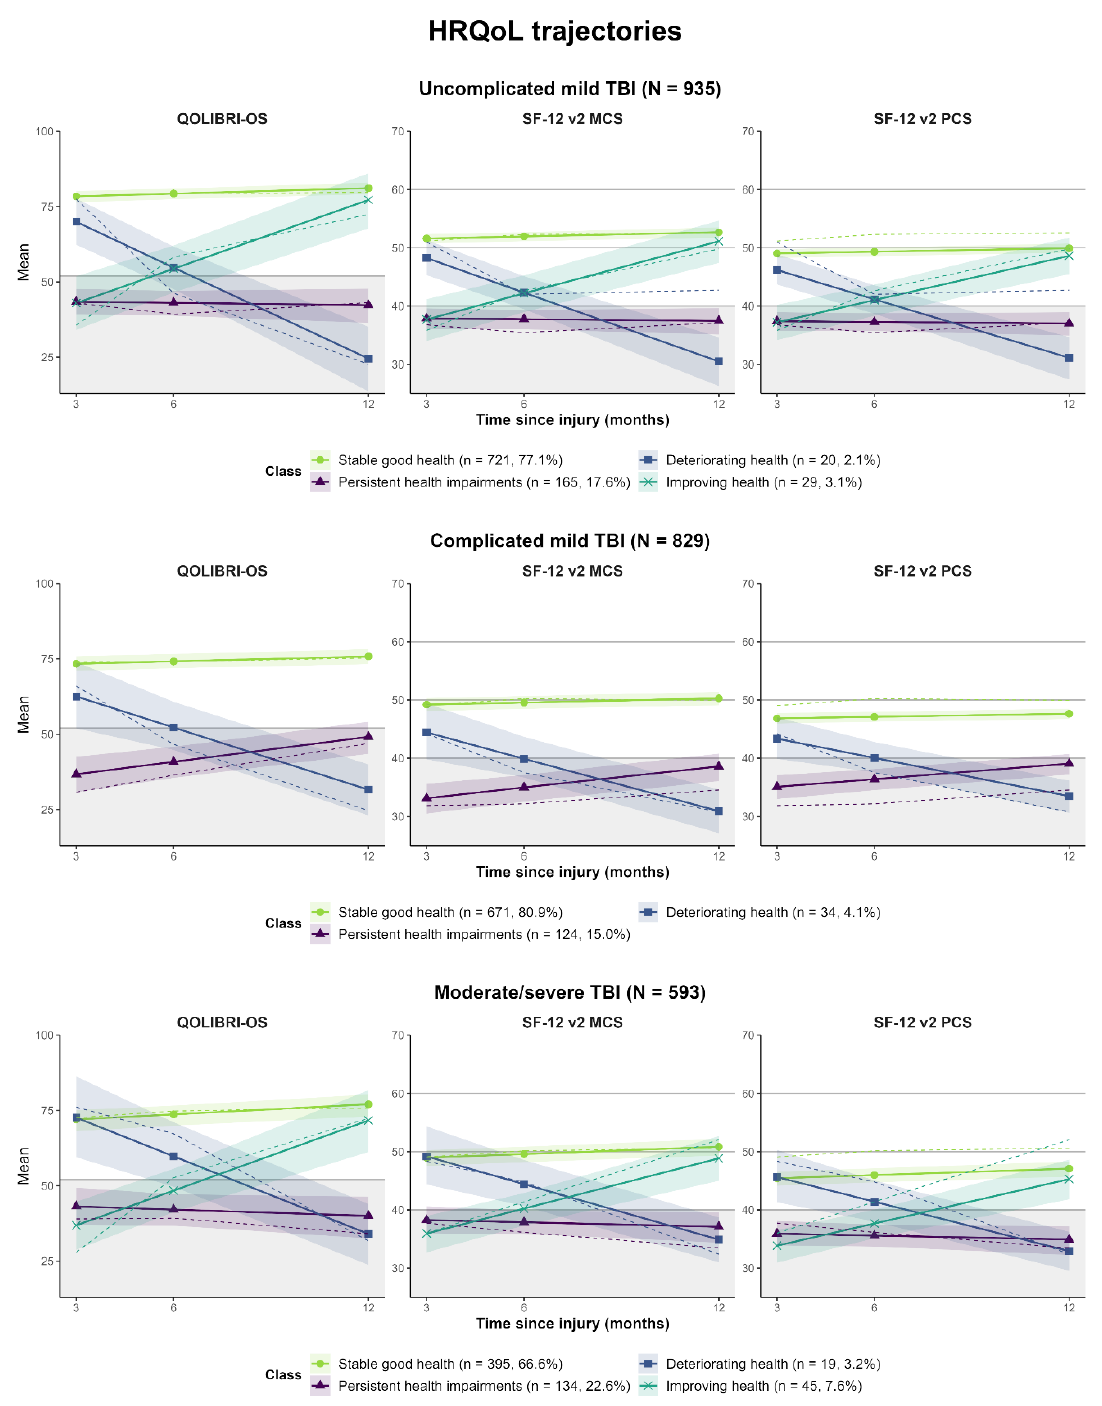
Figure A1. Generic and disease-specific HRQoL trajectories (QOLIBRI-OS, SF-12 v2 MCS/PCS) for the best solutions of model 1 (random intercept, fixed slope) for subgroups with different TBI severity. Solid, colored lines indicate predicted trajectories, dashed lines the observed values. Shaded areas around lines indicate 95% confidence intervals for predicted values. Gray lines mark cut-off for unfavorable values for the QOLIBRI-OS (<53) as well as mean (=50) and standard deviation (+/ − 10) for the SF-12v2 MCS/PCS. Gray area marks values below the cut-off for unfavorable levels of quality of life (QOLIBRI-OS < 52, SF-12v2 MCS/PCS < 50).